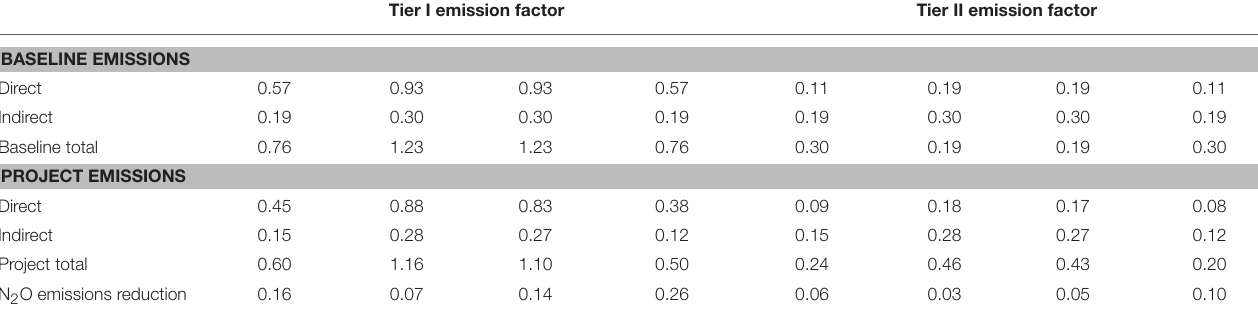
Table 7 . Sample project four, SWWW-Split N, had the highest per hectare payment incentive followed by sample projects SWWW- VR, HRSW-VR, and HRWW-VR ( Table 7 ). At a carbon price of $10 per MgCO 2 e, offset credits generated would be worth